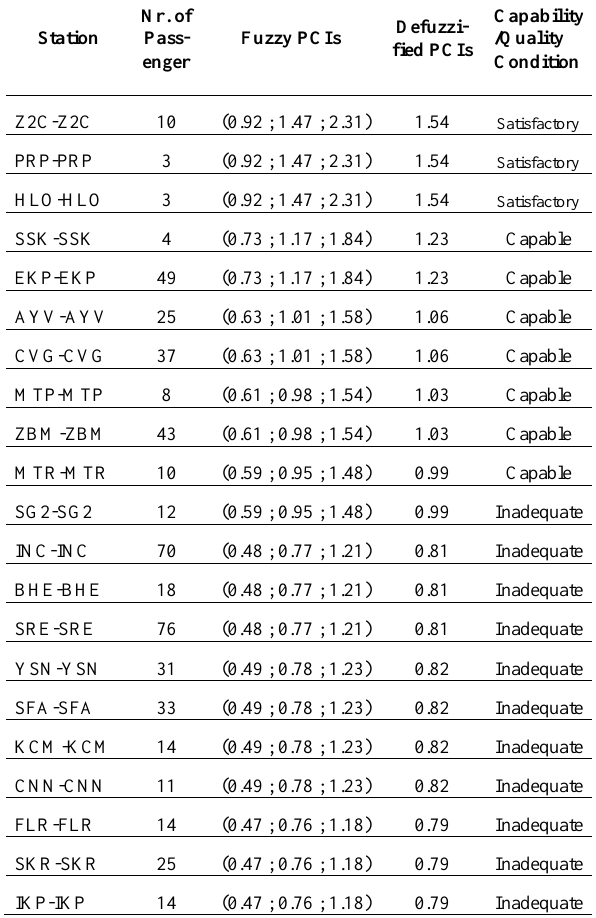
Table 7. Fuzzy process capability indices for route 34-M2.